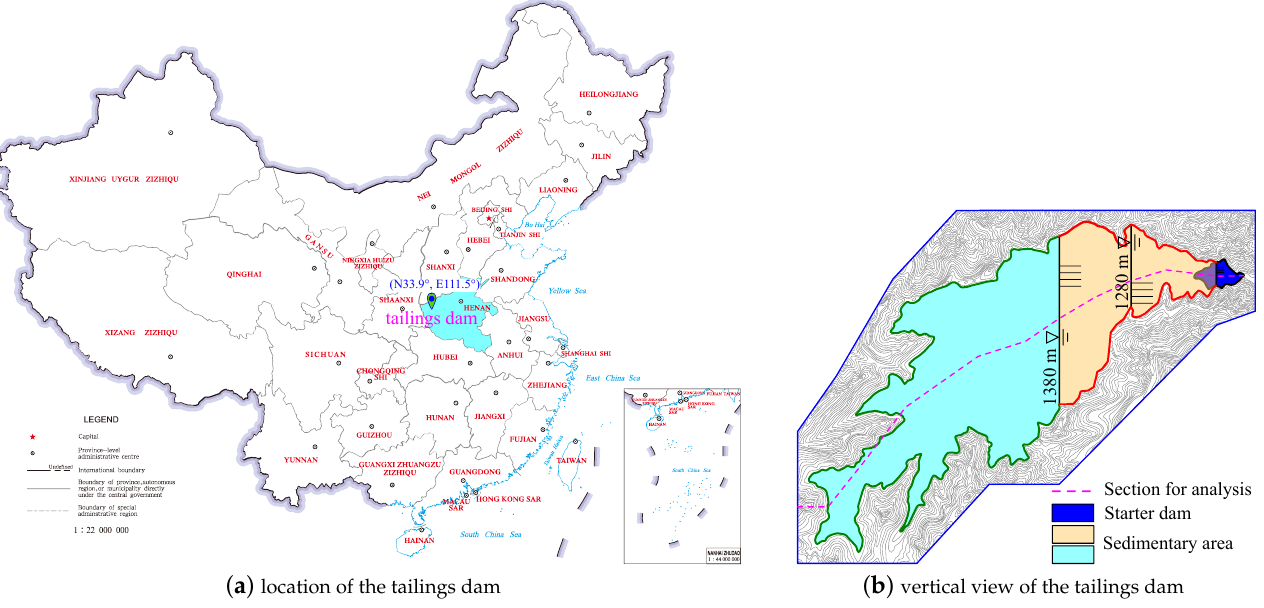
Figure 9. The location and vertical view of the tailings dam for a case